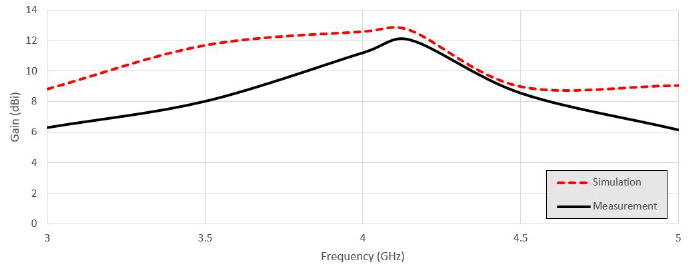
Figure 6. Gain comparison of the microstrip array